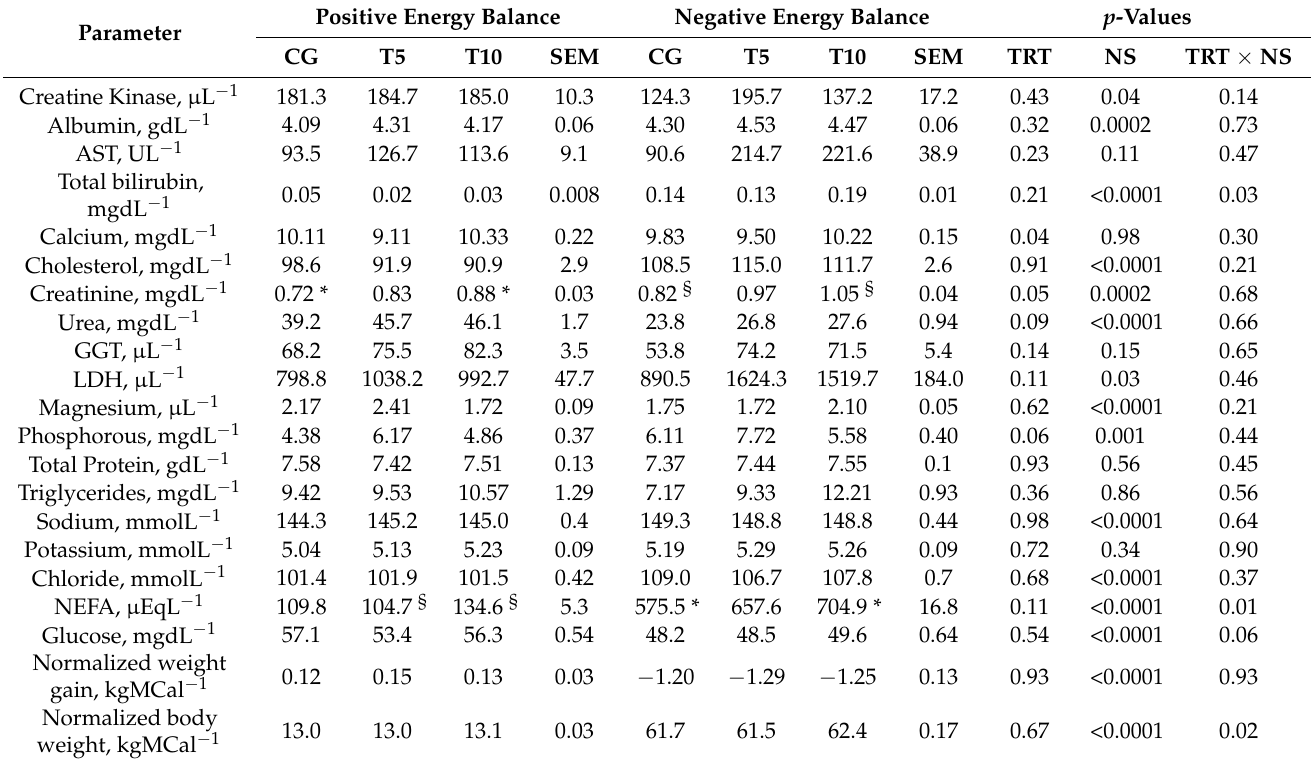
Table 1. Serum parameter, body weight, and non-esterified fatty acids (NEFA) analysis of the control (CG) and the thiamine treated sheep under positive and energy balance nutritional states.